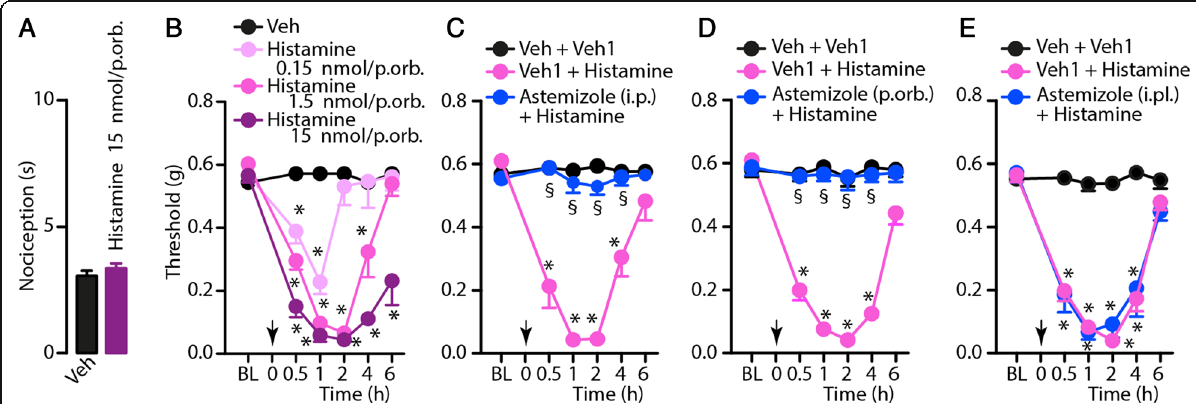
Fig. 3 a Histamine periorbital (p.orb., 10 μ l/15 nmol/site) injection does not evoke spontaneous nociceptive behaviour. b Dose- and time- dependent periorbital mechanical allodynia (PMA) evoked by p.orb. Injection of histamine (10 μ l/0.15 – 15 nmol/site). c - e Effect of pretreatment with intraperitoneal (i.p., 4 μ mol/kg), p.orb. (10 μ l/10 nmol/site) or intraplantar (i.pl., 20 μ l/10 nmol/site) astemizole on PMA evoked by histamine (p.orb., 10 μ l/1.5 nmol/site). C57BL/6J mice were used. Veh is the vehicle of histamine and veh1 is the vehicle of astemizole ( c - e ). Arrows indicate time of histamine administration. Astemizole was given 30 min before histamine. Error bars indicate mean ± s.e.m., n = 6 mice per group. * P < 0.05 vs. Veh or Veh + Veh1, § P < 0.05 vs. Veh1+ histamine; two-way ANOVA with Bonferroni post hoc